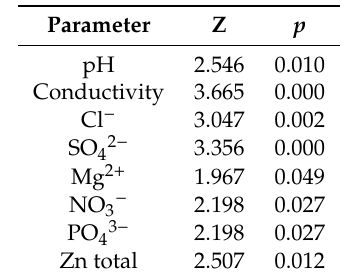
Table 2. Significant differences in the values of studied physico-chemical parameters in water between the UP (CH4, CH5) and DOWN (CH1-CH3) ponds (Mann–Whitney test) . Only significant differences are given.